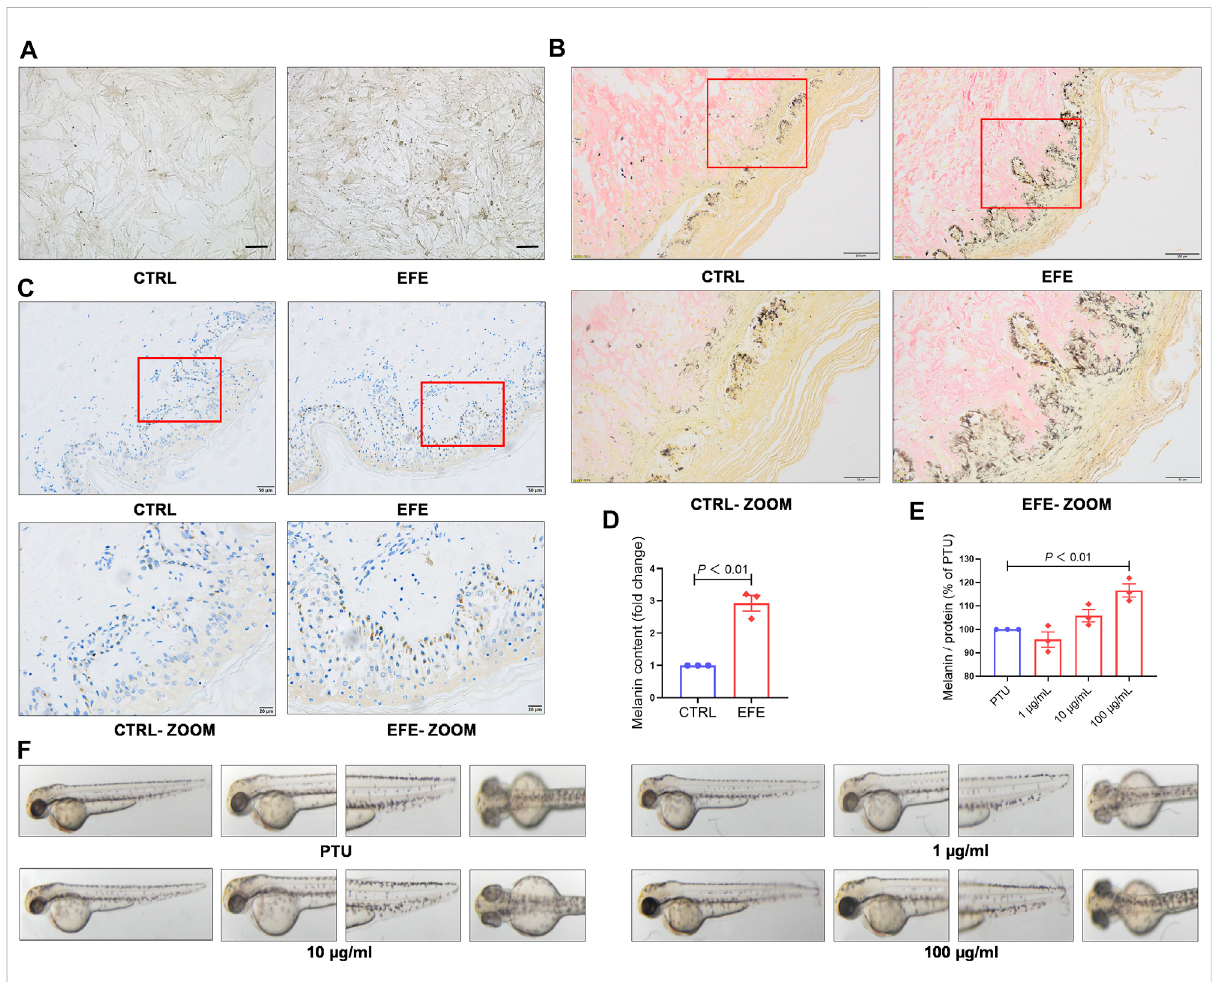
FIGURE 3 EFE causes pigment-darkening effects in human primary melanocyte, human skin-organ culture, perilesional tissue, and depigmented models of zebra fi sh and C57BL/6 mice by activating tyrosinase. (A) Representative images of HMC under light microscope (scale bar = 50 μ m); (B) representative images of healthy human skin tissue for Masson – Fontana staining (CTRL, EFE: 200 ×, scale bar = 100 μ m; CTRL-ZOOM, EFE-ZOOM: 400 ×, scale bar = 50 μ m); (C) representative images of perilesional area of vitiligo patients for immunohistochemistry staining (nucleus: blue, melanin granules: brown black; CTRL, EFE: 200×, scale bar = 50 μ m; CTRL-ZOOM, EFE-ZOOM: 400 ×, scale bar = 20 μ m); (D) melanin particle statistics for Masson – Fontana staining; (E) melanin particle statistics for zebra fi sh in vivo ; (F) representative images of melanin in zebra fi sh.